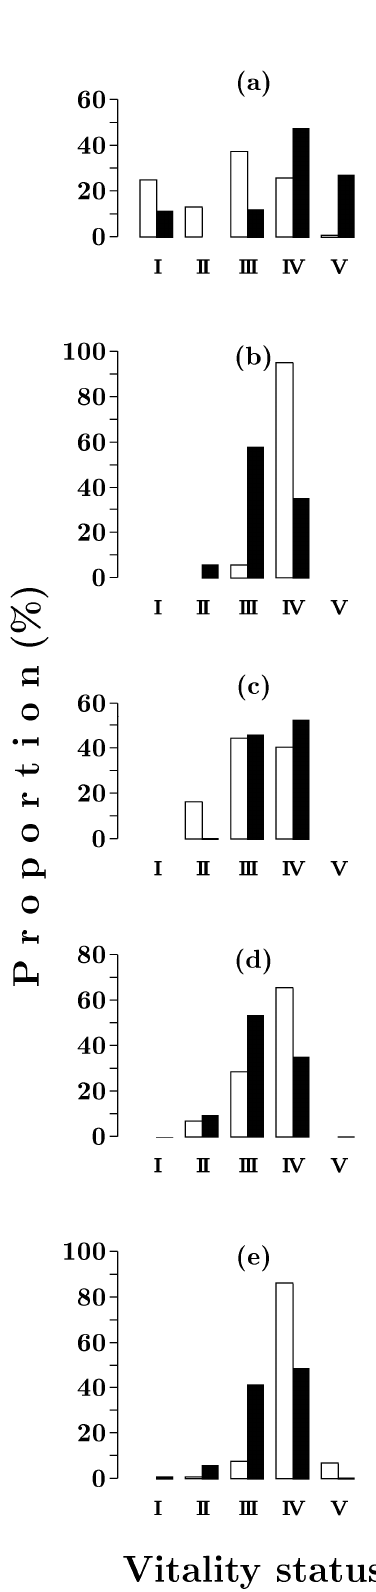
Figure 6. Vitality class distributions of Pinus sylvestris (open bars) and Picea obovata (solid bars) seedlings in Siberian spruce–Scots pine forests with post-fire periods of 8 ( a ), 80 ( b ), 150 ( c ), 200 ( d ) and 380 ( e ) years. I–V—vitality status: I—healthy trees; II—moderately weakened trees; III—strongly weakened trees; IV—dying trees; V—dry trees.